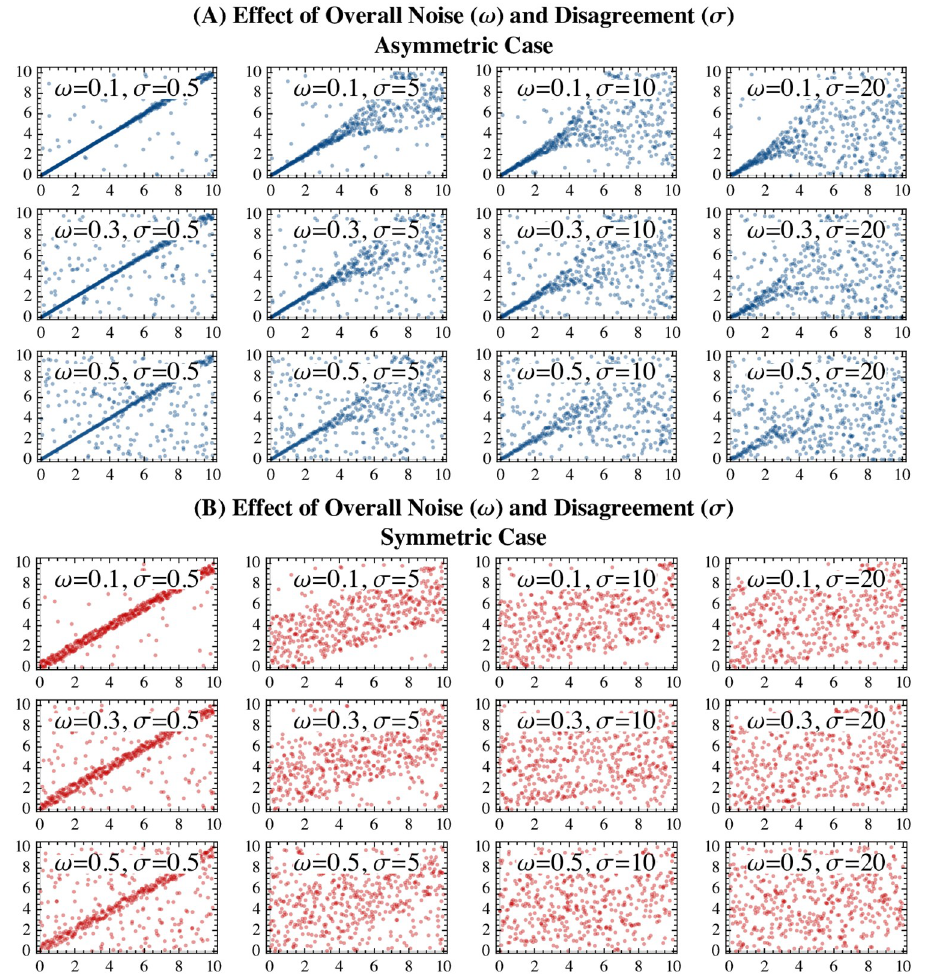
Fig 1. Demonstration of the synthetic agreement data across differences in the parameter ranges and presence of asymmetry. The x-axes all represent the ground truth value of the variable, and the y-axes represent the “observed” values. Data are depicted based on different values of a uniform noise parameter (0 � ω � 1) that governs what proportion of the data is merely uniform noise over the interval [0, 10], and a disagreement parameter ( σ � 0), which governs the variance around the diagonal line. Panel A (upper three rows, shown in blue) depicts the synthetic data in which there was asymmetrical levels of agreement across the score domain. Panel B (lower three rows, shown in red) depict synthetic data in which there was symmetrical agreement over the score